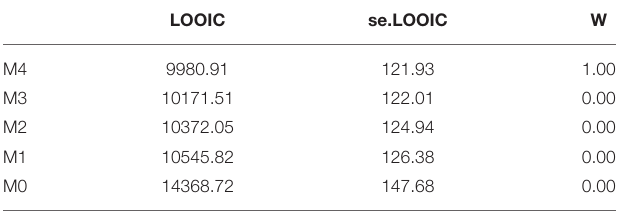
TABLE 1 | Model comparison